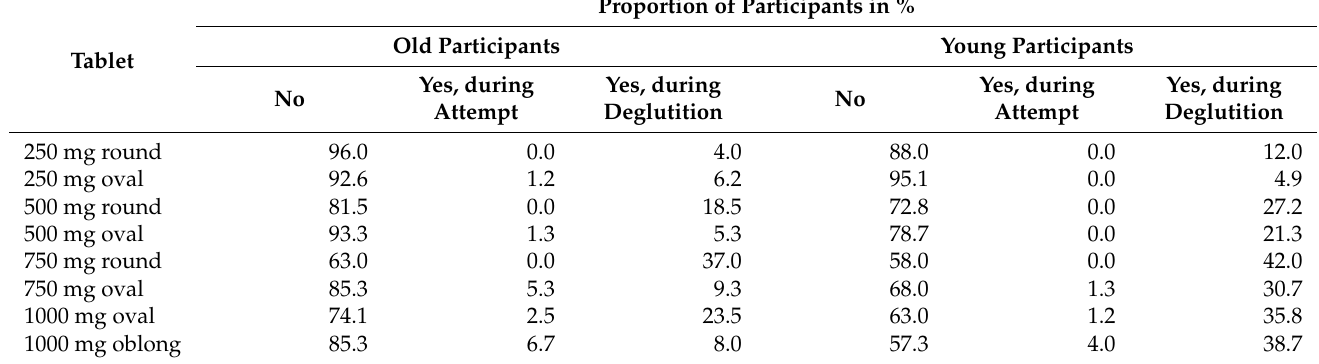
Table 4. Foreign body sensation caused by tablets during swallowing. Data are shown separately for young and old participants including three evaluations per study participant for each